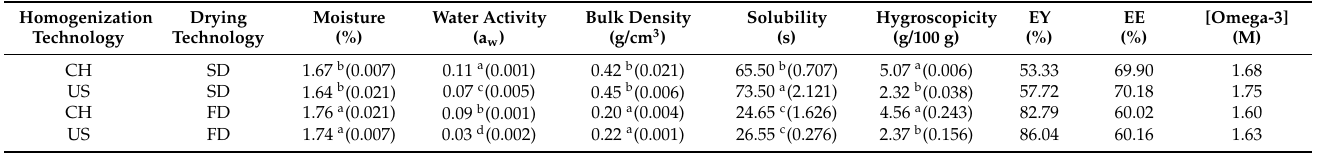
Table 4. Experimental design for SD and FD microcapsules and physicochemical properties evaluated: moisture, a w , solubility, density, hygroscopicity, encapsulation yield (EY), encapsulation efficiency (EE), and concentration of